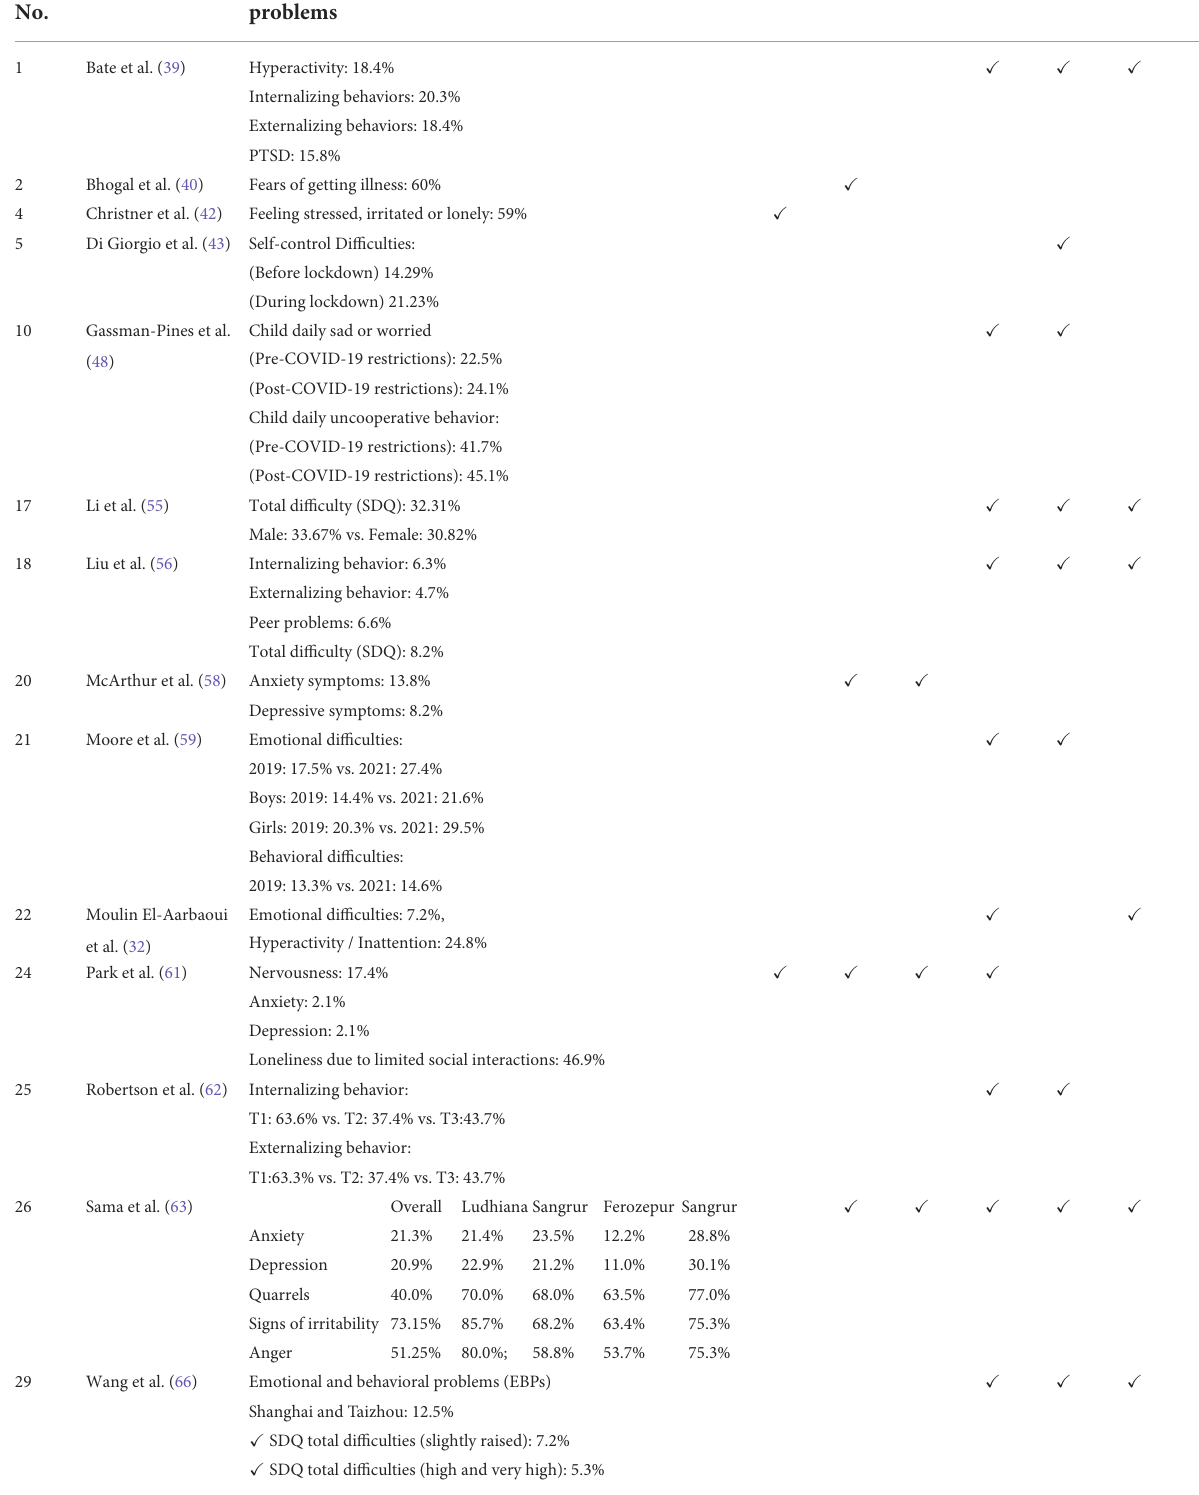
Stress Anx. Dep. Int.